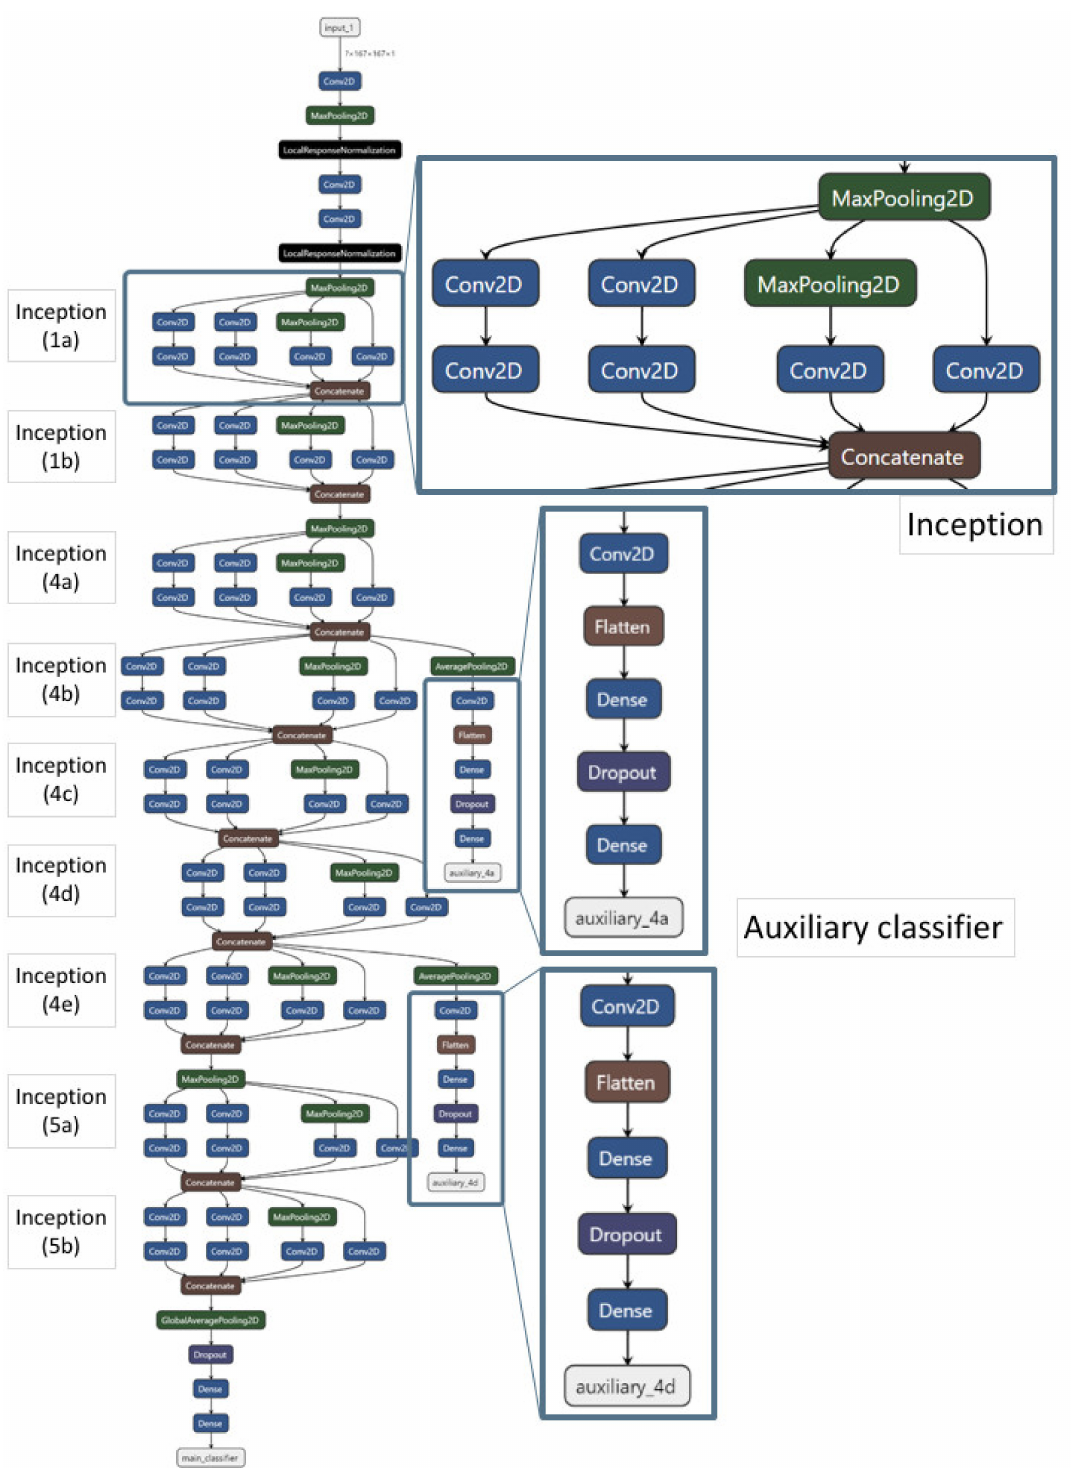
Figure 2. Model structure of GoogLeNet. It contained several 2-dimensional convolution layers (Conv2D), 2-dimensional max pooling layers (MaxPooling2D), 2-dimensional average layers (GlobalAveragePooling2D), Inception-v1 modules (the upper box), and two auxiliary classifiers (two lower